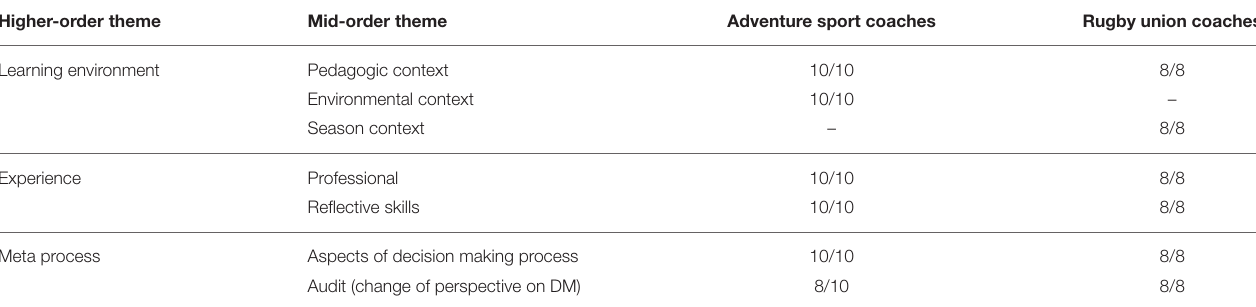
TABLE 2 | Summary comparison of key themes for adventure sport and rugby